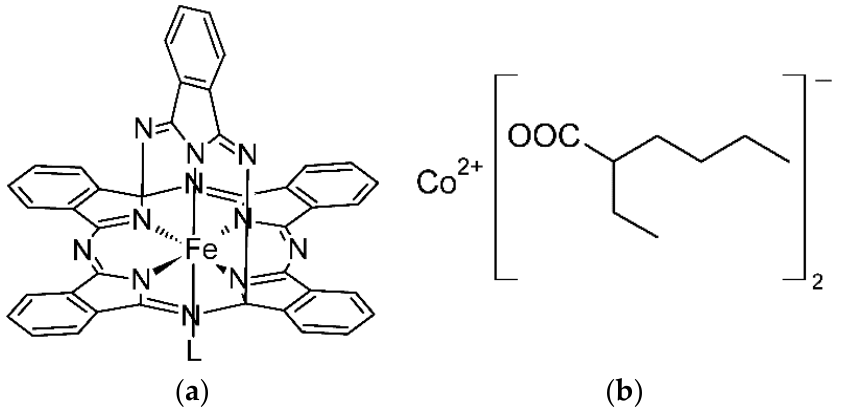
Figure 1. Chemical formulas of: ( a ) phthalocyaninato iron(III) complex (Fe-diiPc); ( b ) cobalt(II) 2-ethylhexanoate (Co-2EH).